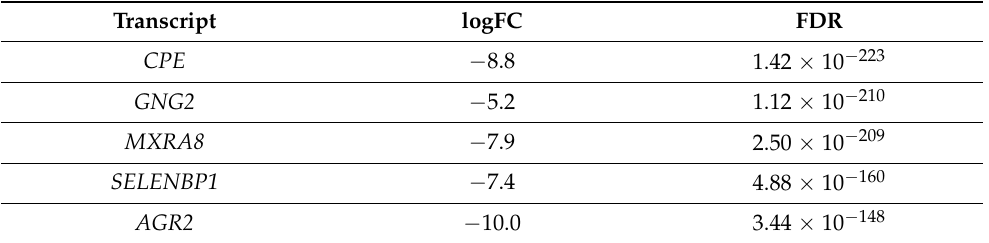
Table 2. Top five genes differentially expressed in MDA-231c141 vs. MDA-231EV tumors.